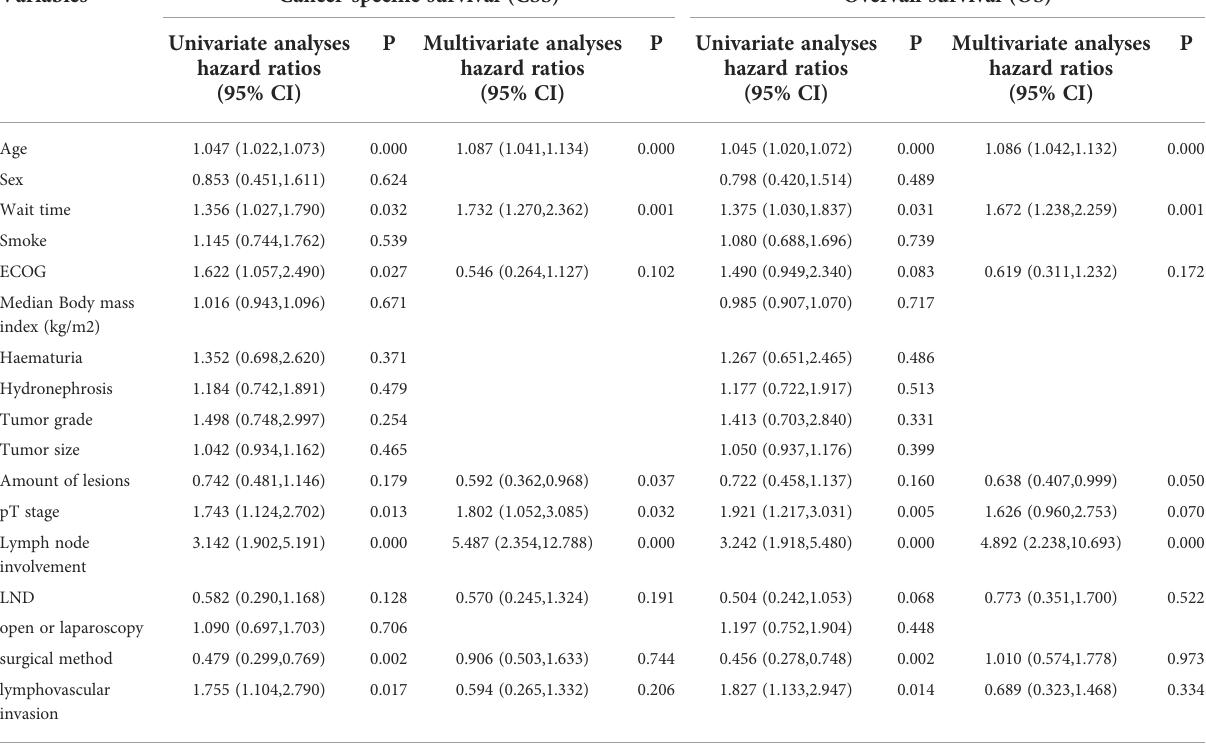
TABLE 2 Multivariable Cox model for cancer-speci fi c survival and overall survival.